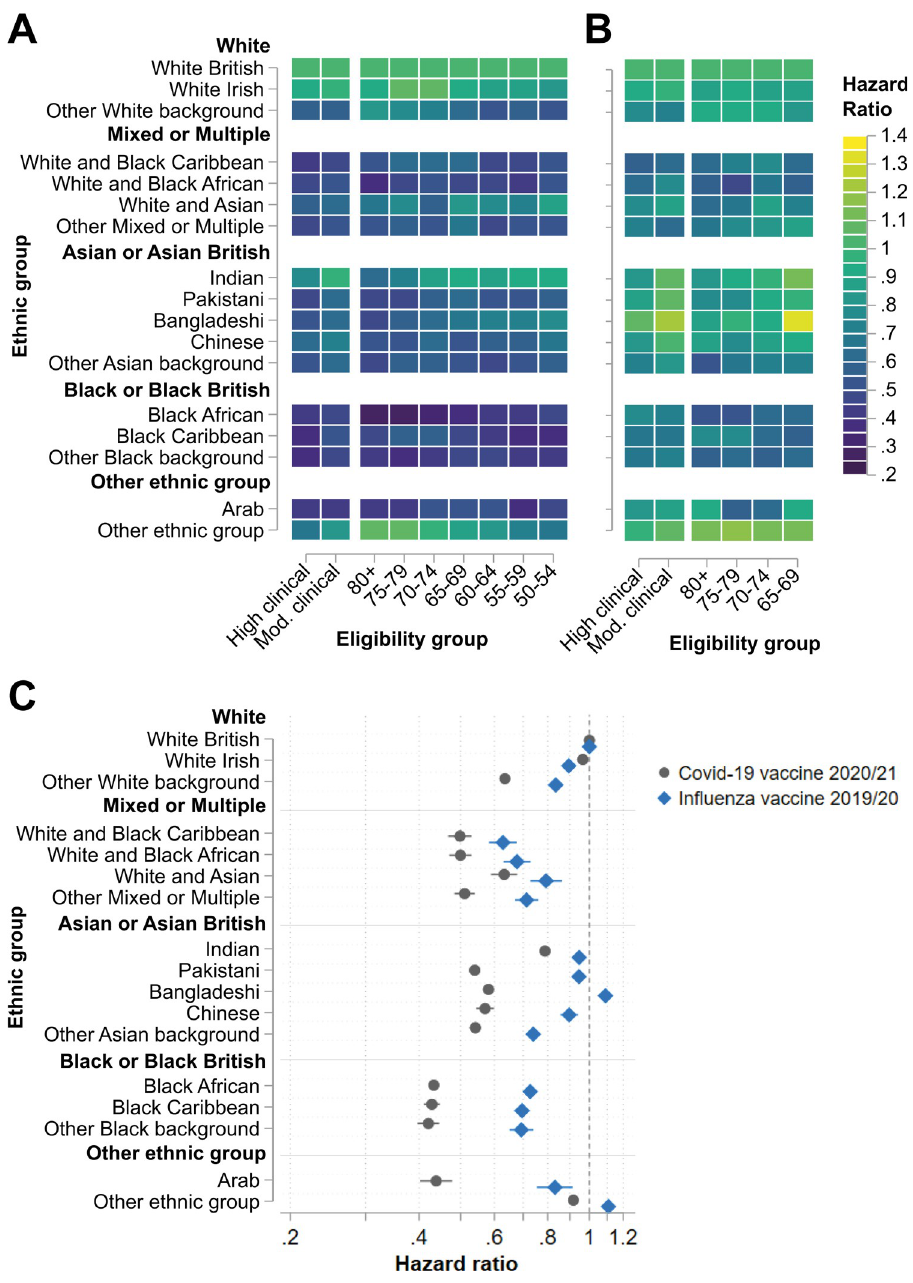
Fig 1. Associations between ethnic group and vaccine uptake. Hazard ratios with 95% confidence intervals from Cox proportional hazards models estimating time to vaccination across ethnic groups stratified by vaccine eligibility group for (A) COVID-19 vaccine and (B) 2019/2020 seasonal influenza vaccine. (C) Hazard ratios with 95% confidence intervals from Cox proportional hazards models estimating time to vaccination across ethnic groups adjusted by vaccine eligibility group amongst individuals eligible for both the COVID-19 and 2019/2020 seasonal influenza vaccines. High clinical = high clinical risk. Mod. clinical = moderate clinical risk.